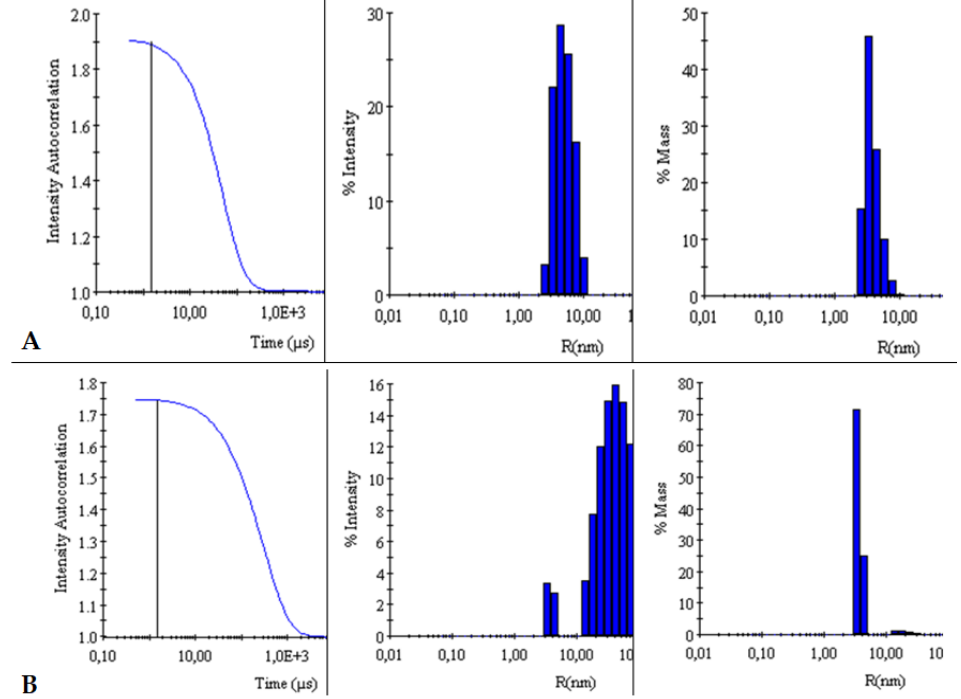
Figure 7. Comparison of intensity autocorrelation curves, % of intensity and, % of the mass of: ( A ): BSA-TY and ( B ): BSA-TY-Ag.